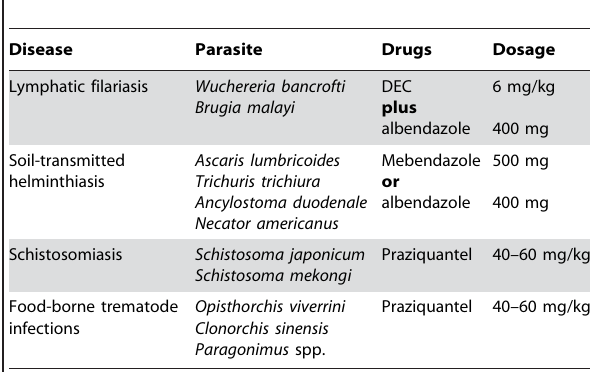
Table 2. Drugs Utilized for Preventive Chemotherapy for Different Neglected Diseases Transmitted in WPR